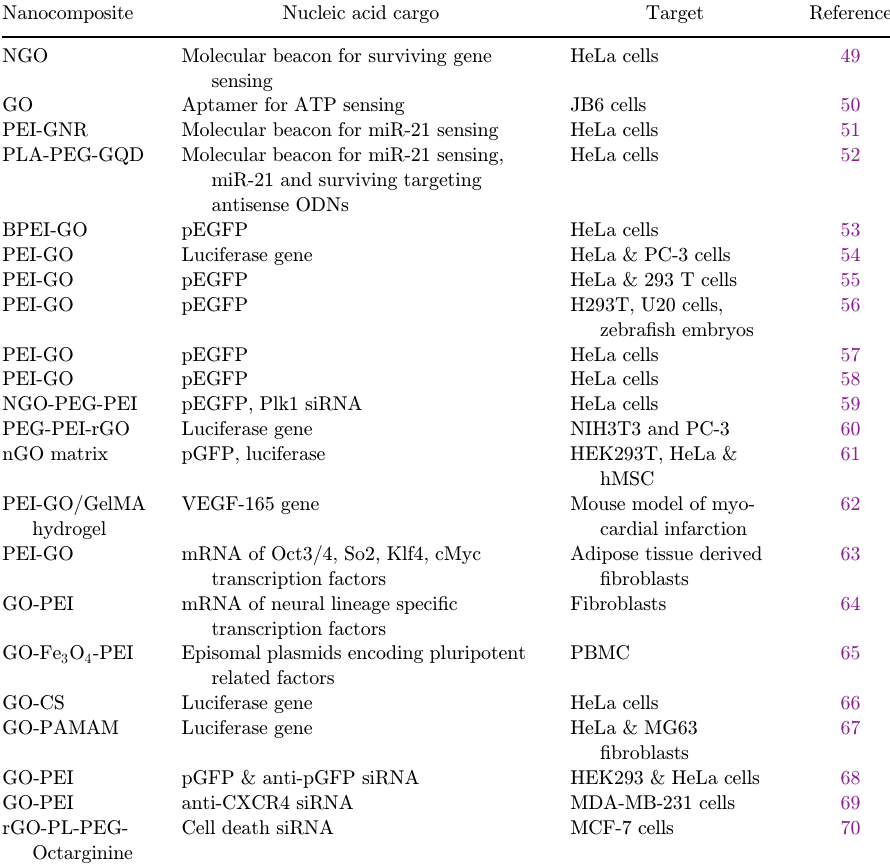
Table 2. Summary of graphene-based nanomaterials for nucleic acid